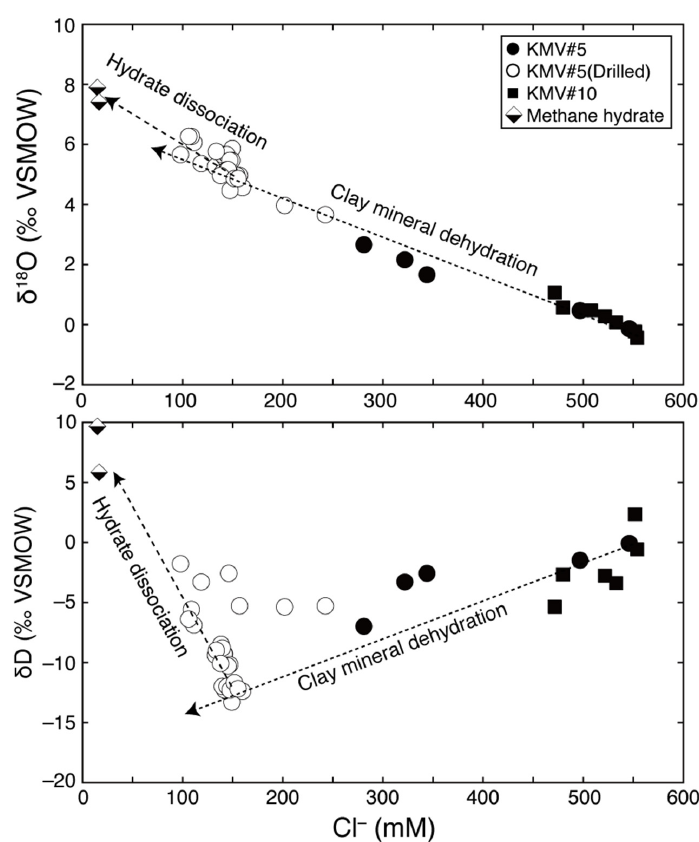
Figure 3. Relationships of δ 18 O vs. Cl ‒ ( top ) and δ D vs. Cl ‒ ( bottom ) in the samples from this